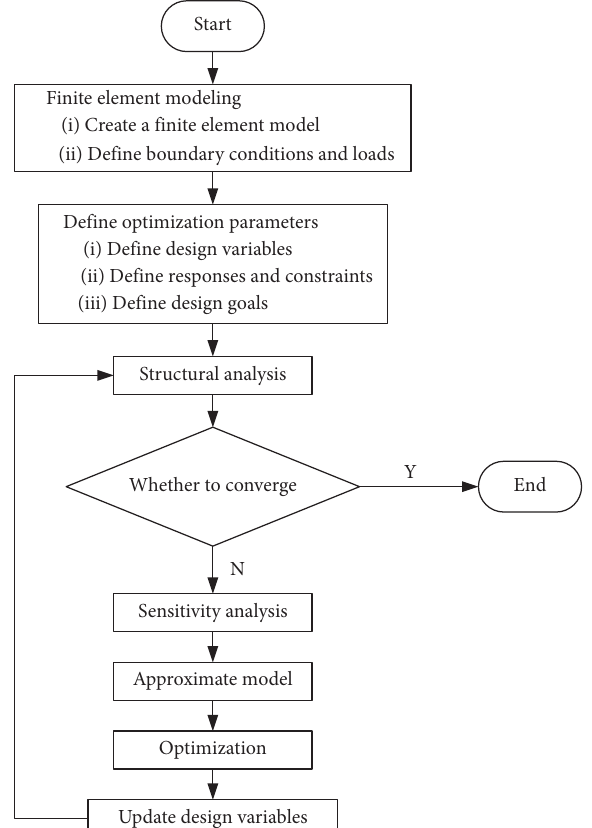
Figure 8: Topology optimization